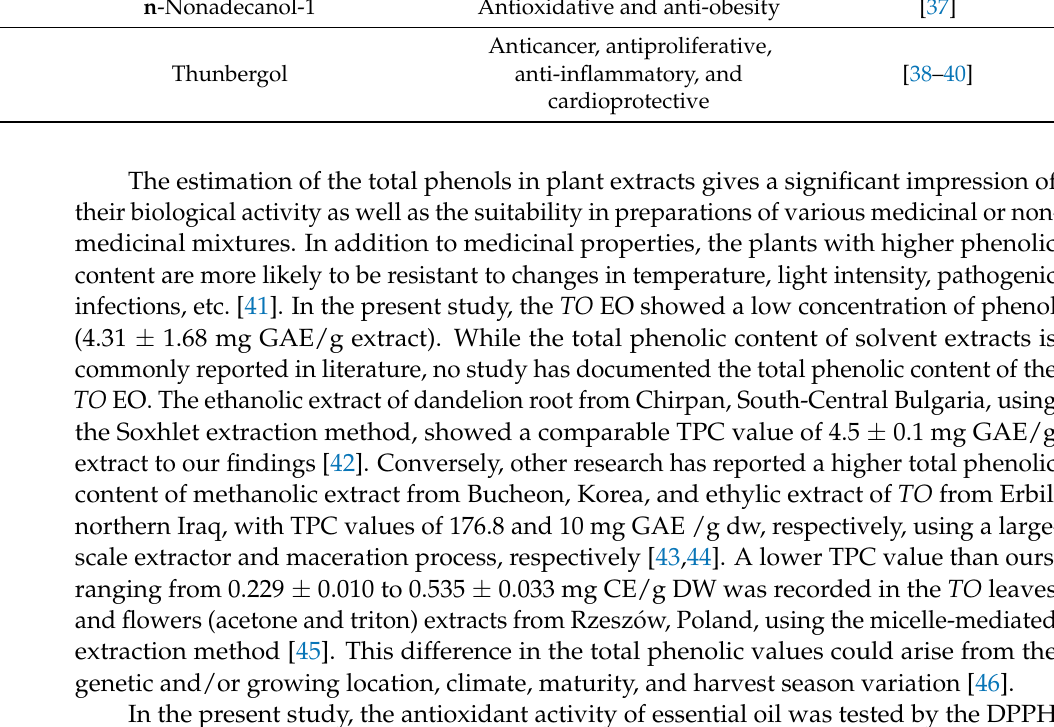
Table 6. Bioactivities of the main constituents of the essential oil of the plant reported in the literature. Examples of Compounds Identified Groups in Our Study